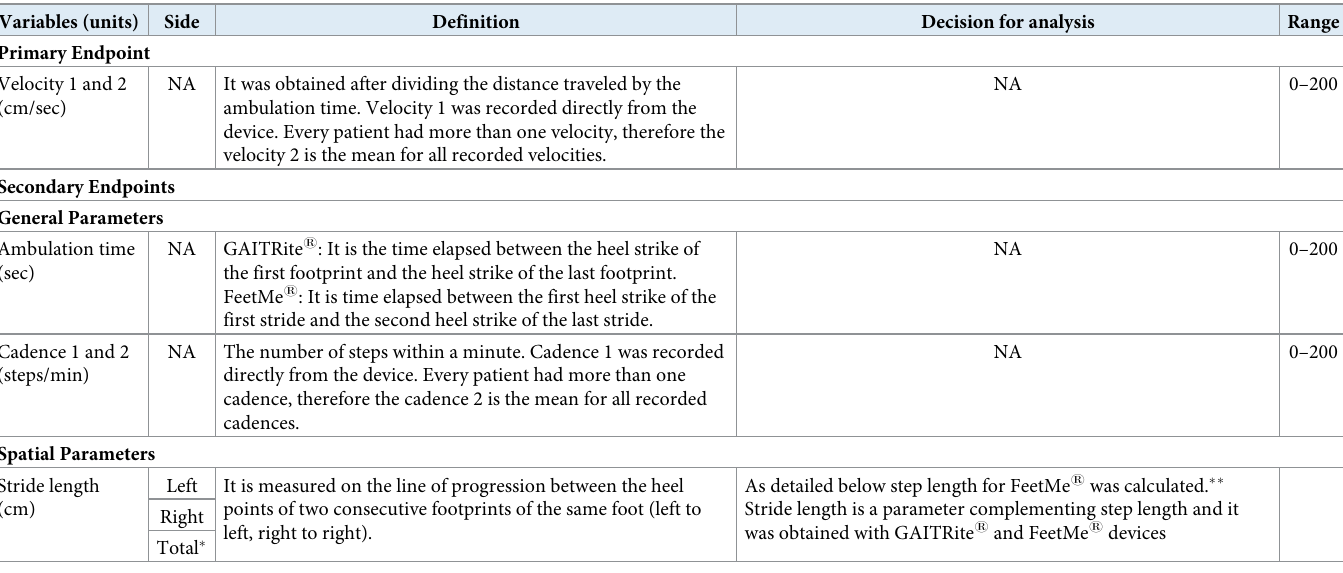
Table 1. Gait parameters recorded by GAITRite 1 and FeetMe 1 Monitor